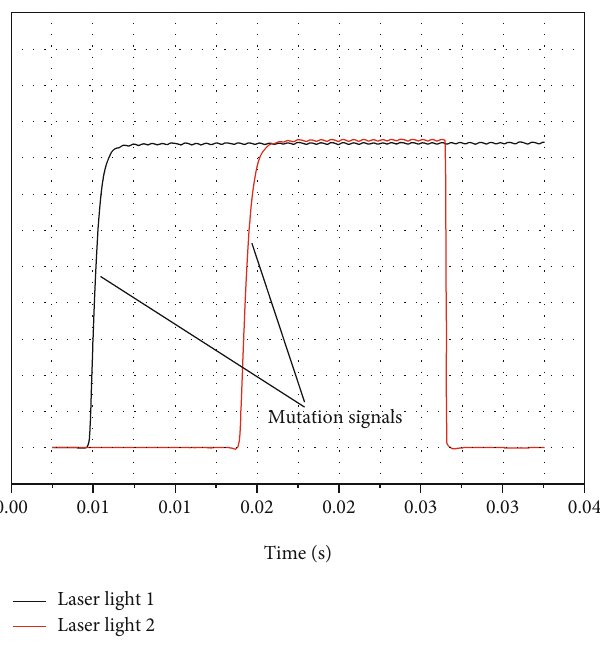
Figure 9: Laser signal of velocity observation.